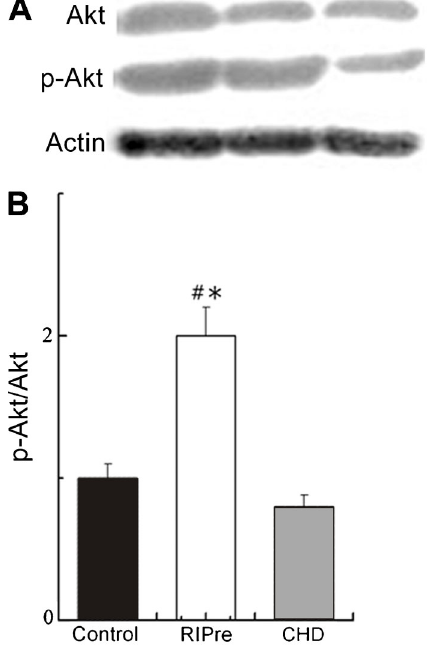
Figure 1. A , Effects of remote ischemic preconditioning (RIPre) on endothelial expression of endothelial nitric oxide synthase (eNOS) mRNA as measured by semiquantitative RT-PCR. RIPre caused an increase in eNOS mRNA expression. B , Relative expression of eNOS mRNA (density ratio, eNOS:GADPH) is reported as means±SE for n=20 in each group. *P , 0.05 vs CHD (Student-Newman-Keuls test). Note that the example does not exactly reflect the mean value of all samples.